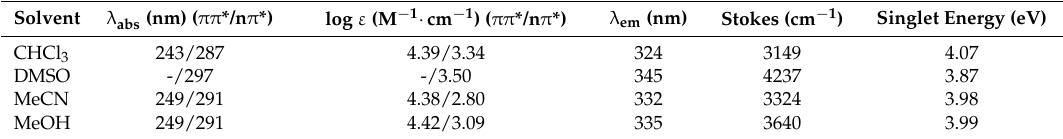
Table 1. Photophysical data of sensor 1 . 1